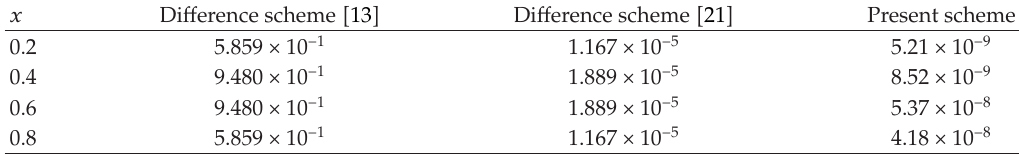
Table 2: The absolute error ofExample 7 for di ff erence schemes and our scheme at t (cid:3) 0 . 5.